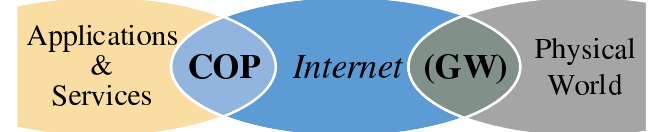
Figure 2. Internet of Things concept using the Internet as a link between (physical) objects, and novel application and services using a common operational picture